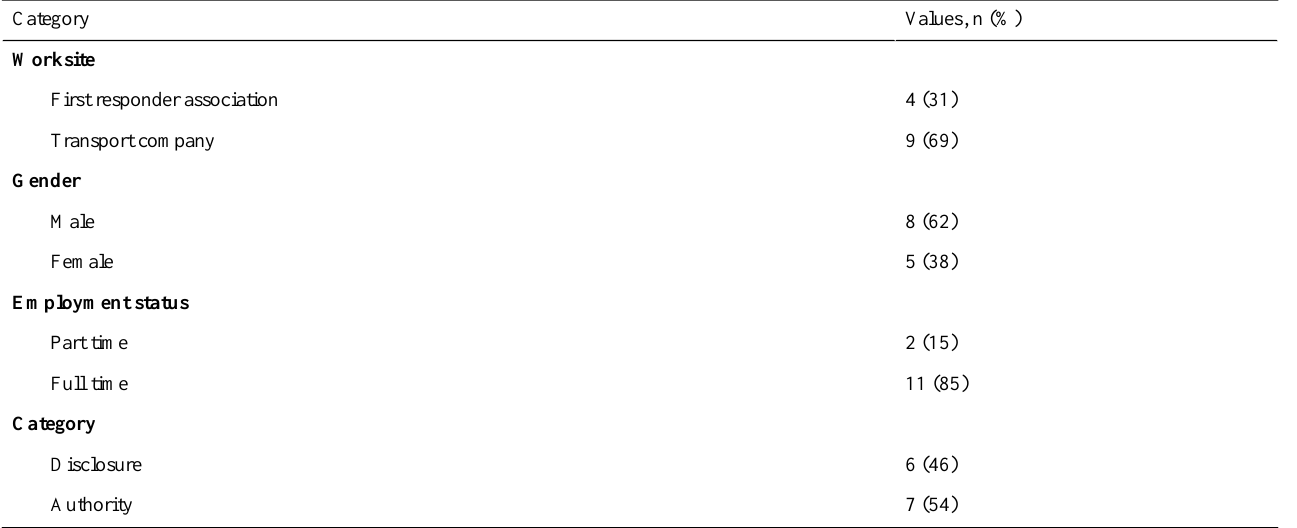
Table 1. Demographic information for